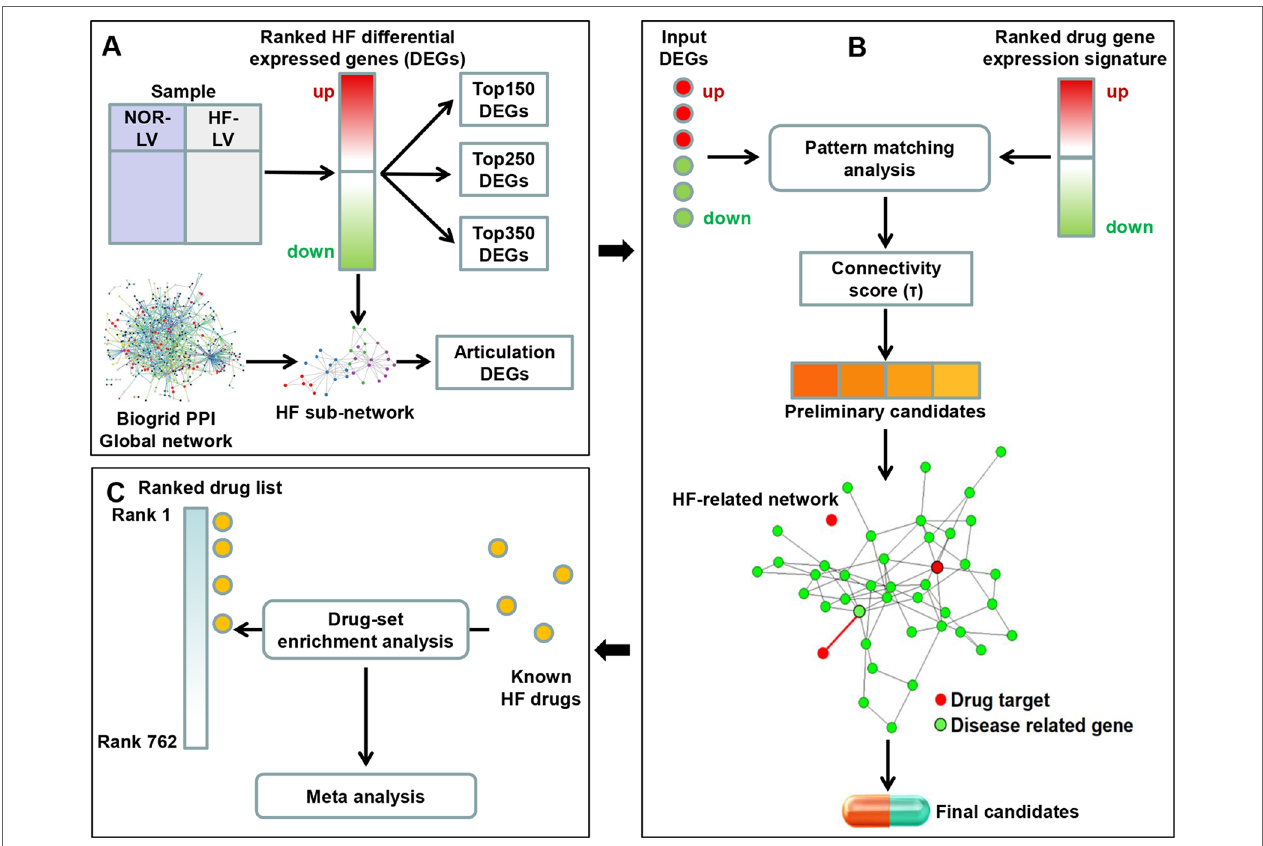
FIGURE 1 | Framework overview. (A) We compared the gene expression profile of heart failure (HF) and normal human left ventricular (LV) tissues to obtain the differential expression genes (DEGs). The K-most top (up- and downregulated) DEGs were obtained according to the fold change values. We then extracted a HF subnetwork from the global protein–protein interaction network using all DEGs. Articulation DEGs of the subnetwork were extracted as inputs to perform subsequent drug repositioning analysis along with top K genes ( K was set as 150, 250 and 350). (B) A pattern matching analysis was applied on input HF DEGs and drug-induced gene expression signatures. Connectivity score ( τ ) was calculated to assess the reversal of gene expression patterns and to select the preliminary candidates. Then, the interaction between the targets of preliminary candidates and HF-related network was investigated. Preliminary candidates whose targets located in the HF-related network were selected as final candidates. (C) Drug-set enrichment analysis was applied to determine whether known HF drugs are located higher in the whole drug list ranked by τ . Results across all datasets were aggregated using